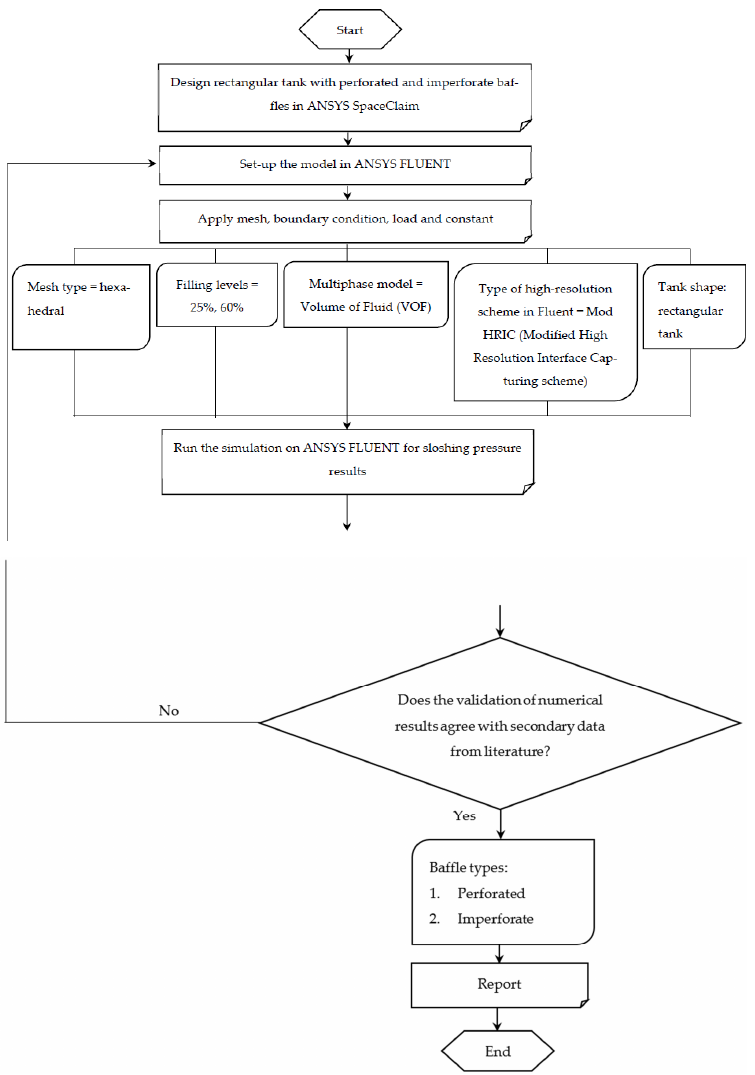
Figure 1. Numerical flow of rectangular tank with perforated and imperforate baffles in ANSYS Fluent software.